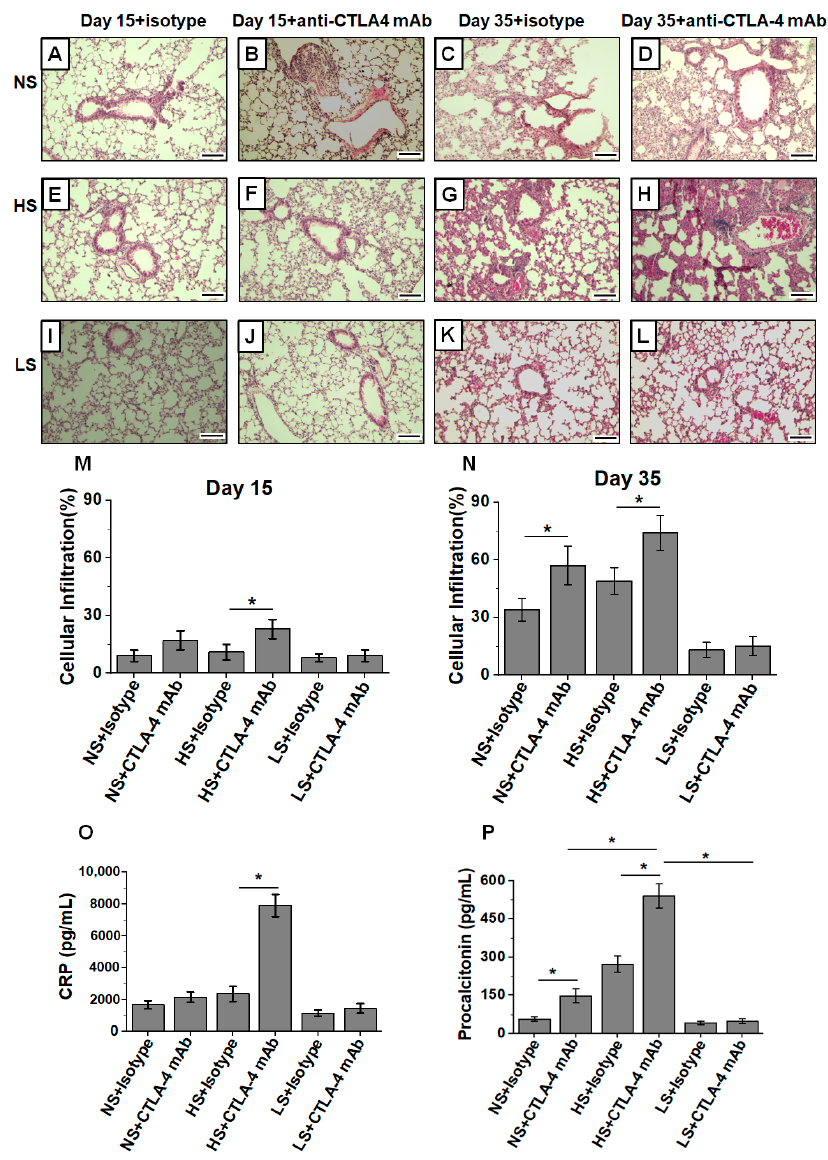
Figure 3. Increased pneumonitis and lung infiltration in tumor-bearing mice on HS diet and treated with anti-CTLA4 mAb based ICI therapy. Lungs are harvested on days 15 and 35 from mice injected with Py230 tumor cells in the mammary fat pad flank region of C57Bl/6 mice and treated with either isotype or anti-CTLA4 mAb i.p. on days 7, 10 and 13. ( A – D ) Tumor-bearing mice were fed on NS diet, lungs were harvested on day 15 (isotype, ( A ), and anti-CTLA4 mAb, ( B )) and day 35 (isotype, ( C ), and anti-CTLA4 mAb, ( D )). ( E – H ) Tumor-bearing mice were fed on HS diet, lungs were harvested on day 15 (isotype, ( E ), and anti-CTLA4 mAb, ( F )) and day 35 (isotype, ( G ), and anti-CTLA4 mAb, ( H )). ( I – L ) Tumor-bearing mice were fed on LS diet, lungs were harvested on day 15 (isotype, ( I ), and anti-CTLA4 mAb, ( J )) and day 35 (isotype, ( K ), and anti-CTLA4 mAb, ( L )). The slides were stained by H&E, and cell infiltration was measured under high power (40 × ) field. ( M , N ) Morphometric analysis for cellular infiltration on day 15 ( M ) and day 35 ( N ). The data are represented as a mean ± SEM for n = 6, with each slide read at 5 different high power fields and divided by 5. Scale bar = 200 µ m. Statistical analysis performed by one-way ANOVA for multiple comparisons (*) p -value < 0.05. ( O , P ) Biochemical analysis of inflammatory markers, c-reactive protein (CRP) ( O ) and procalcitonin ( P ) in the blood from various experimental cohorts. Data analyzed by one-way ANOVA for multiple comparisons; data presented as mean ± SEM, n = 8 per cohort, (*) p -value <